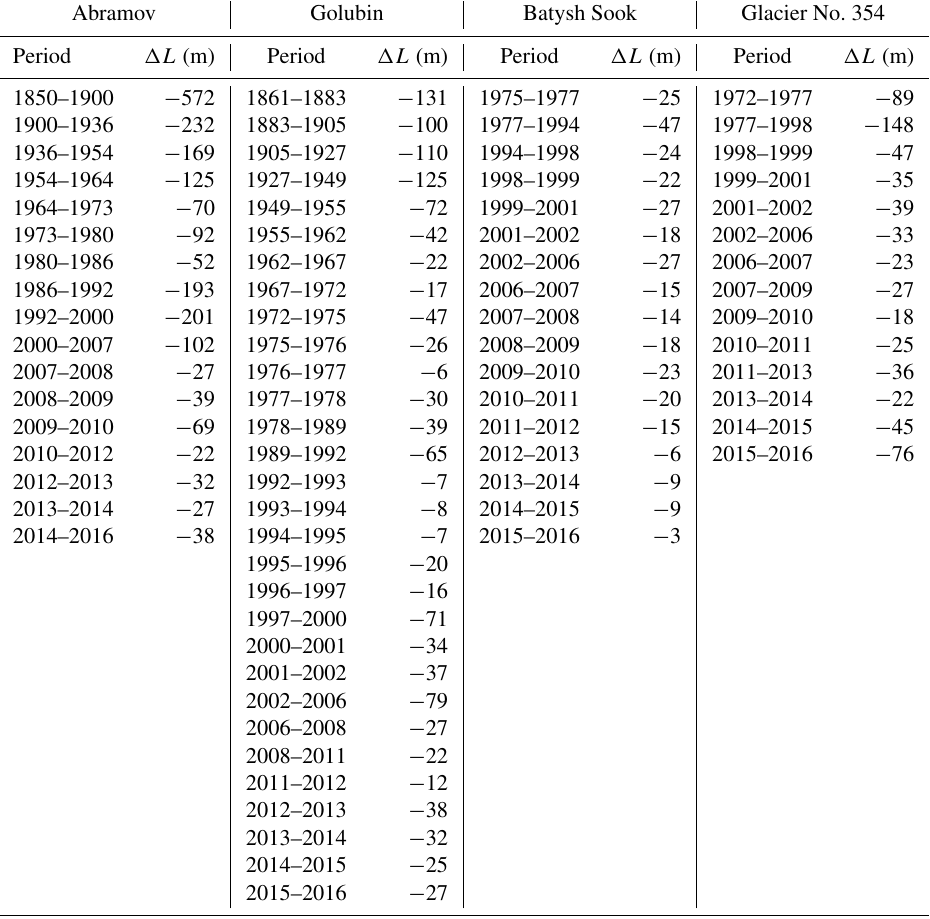
Table 5. Length change (cid:49)L measurements for Abramov, Golubin, Batysh Sook and Glacier No. 354 based on GPS surveys, satellite images and